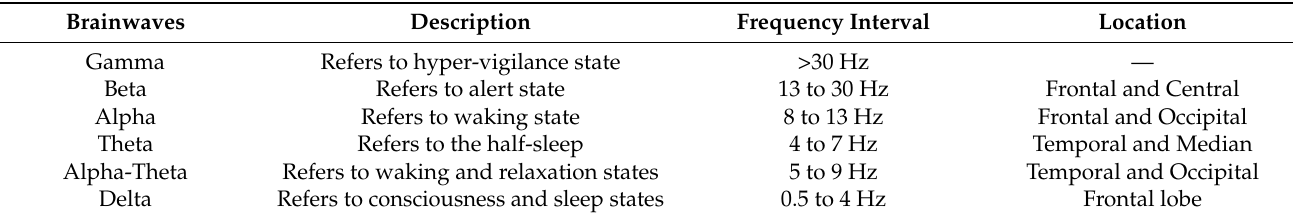
Table 2. Characteristics of brain